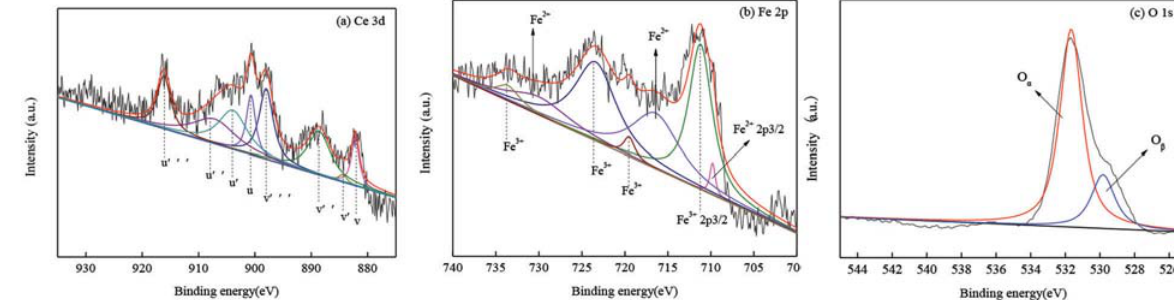
Figure 17: XPS diagram of Sample 3: (a) Ce 3d, (b) Fe 2p, and (c) O 1s.